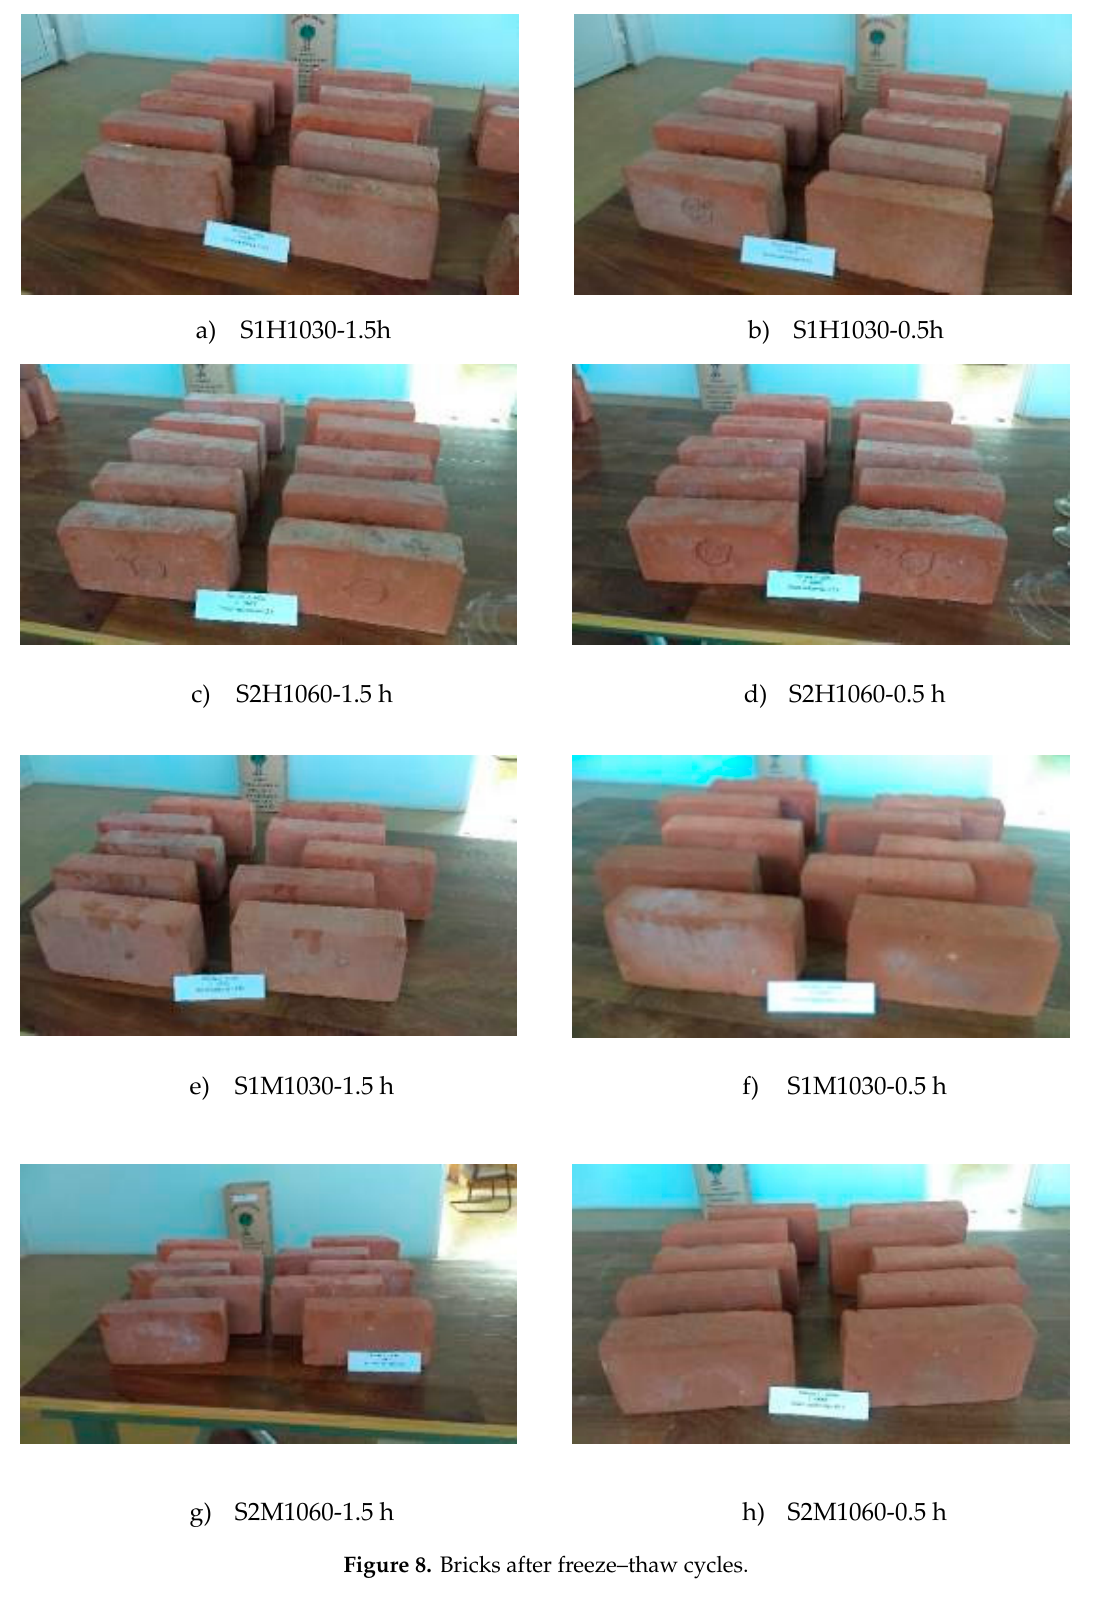
Figure 8. Bricks after freeze–thaw cycles.